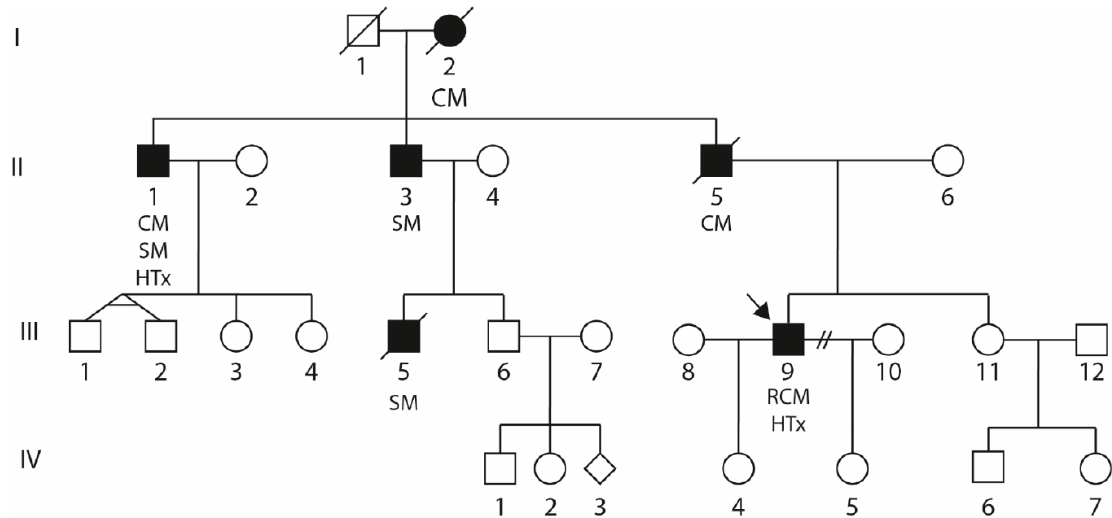
Figure 2. Pedigree of the described family. Circles represent females, squares represent males, and rhombs represent unknown gender. Black-filled symbols indicate a cardiac or skeletal muscle phenotype. Diagonal slashes indicate deceased people. The index patient (III-9) is marked with an arrow and carries DES -c.735G>C. CM = Cardiomyopathy; HTx = Heart transplantation; SM = Skeletal myopathy; and RCM = Restrictive cardiomyopathy.